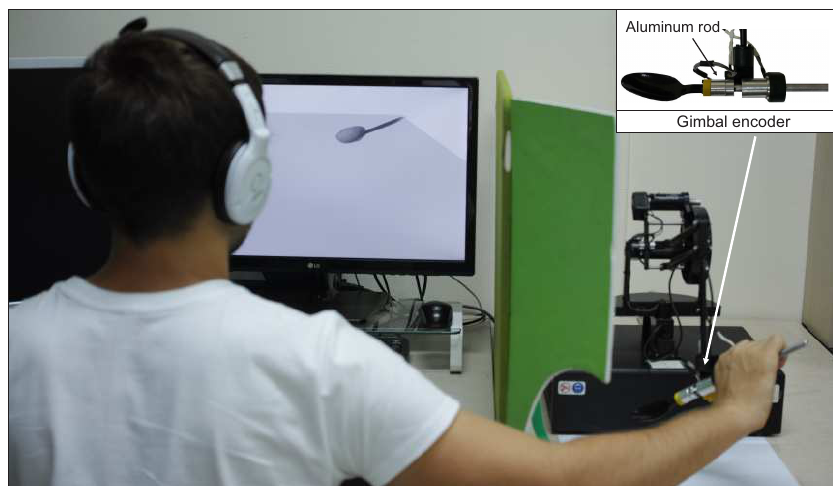
Figure 8. Hardware setup for the experiment. A tool is attached to the gimbal encoder (see top-right) during interaction with a real tool, and detached when the subject interacts with a virtual